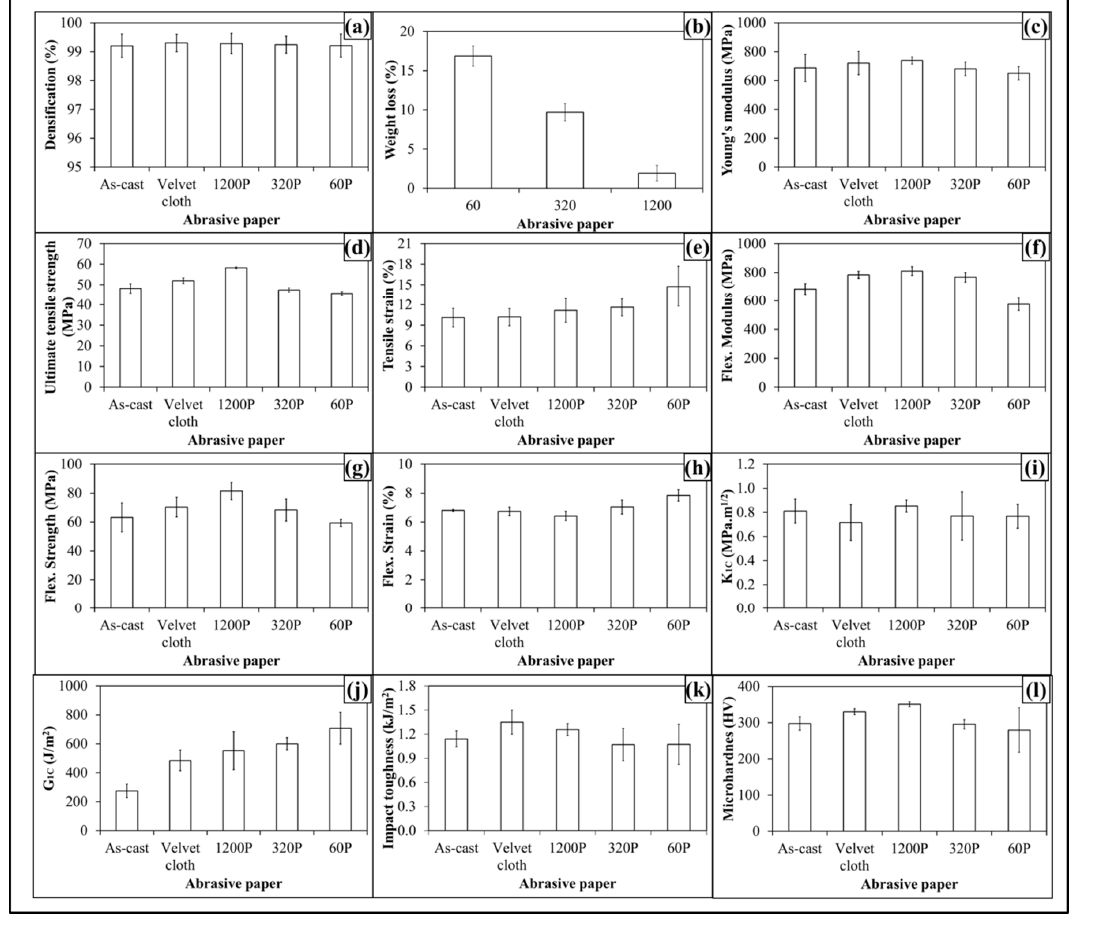
Figure 11. ( a ) Densification; ( b ) Weight loss (%); ( c – l ) Mechanical properties of 0.1 wt % clay-EP nanocomposites; ( c ) Young’s modulus (MPa); ( d ) UTS (MPa); ( e ) Tensile strain (%); ( f ) Flexural modulus (MPa); ( g ) Flexural strength (MPa); ( h ) Flexural strain (%); ( i ) K 1C (MPa.m 1/2 ); ( j ) G 1C (J/m 2 ); ( k ) Charpy impact toughness (kJ/m 2 ); ( l ) Microhardness (HV). ( k ) Charpy impact toughness (kJ/m 2 ); ( l ) Microhardness